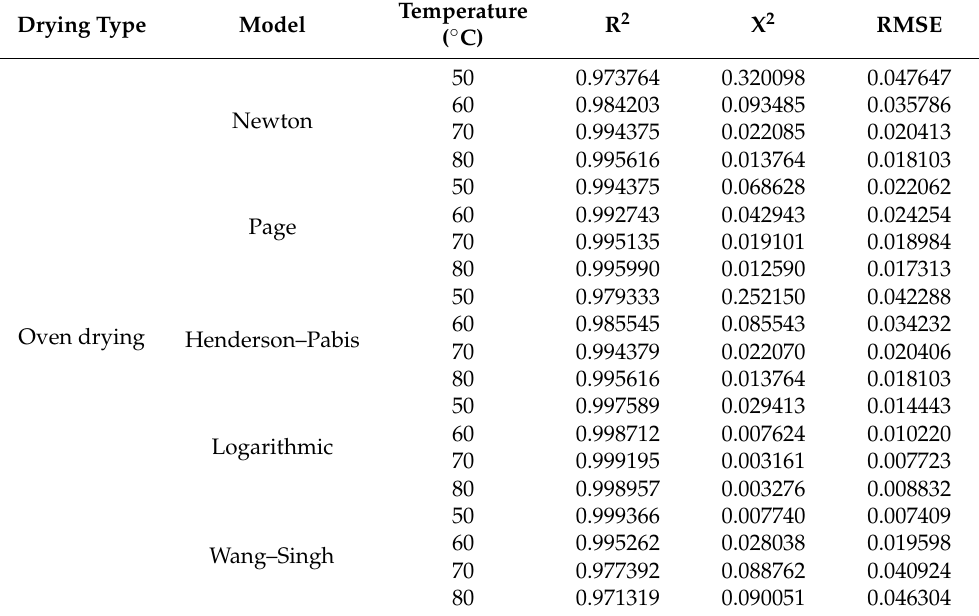
Table 2. R 2 , X 2 , and RMSE values of the drying curve of oven-dried and IR-dried